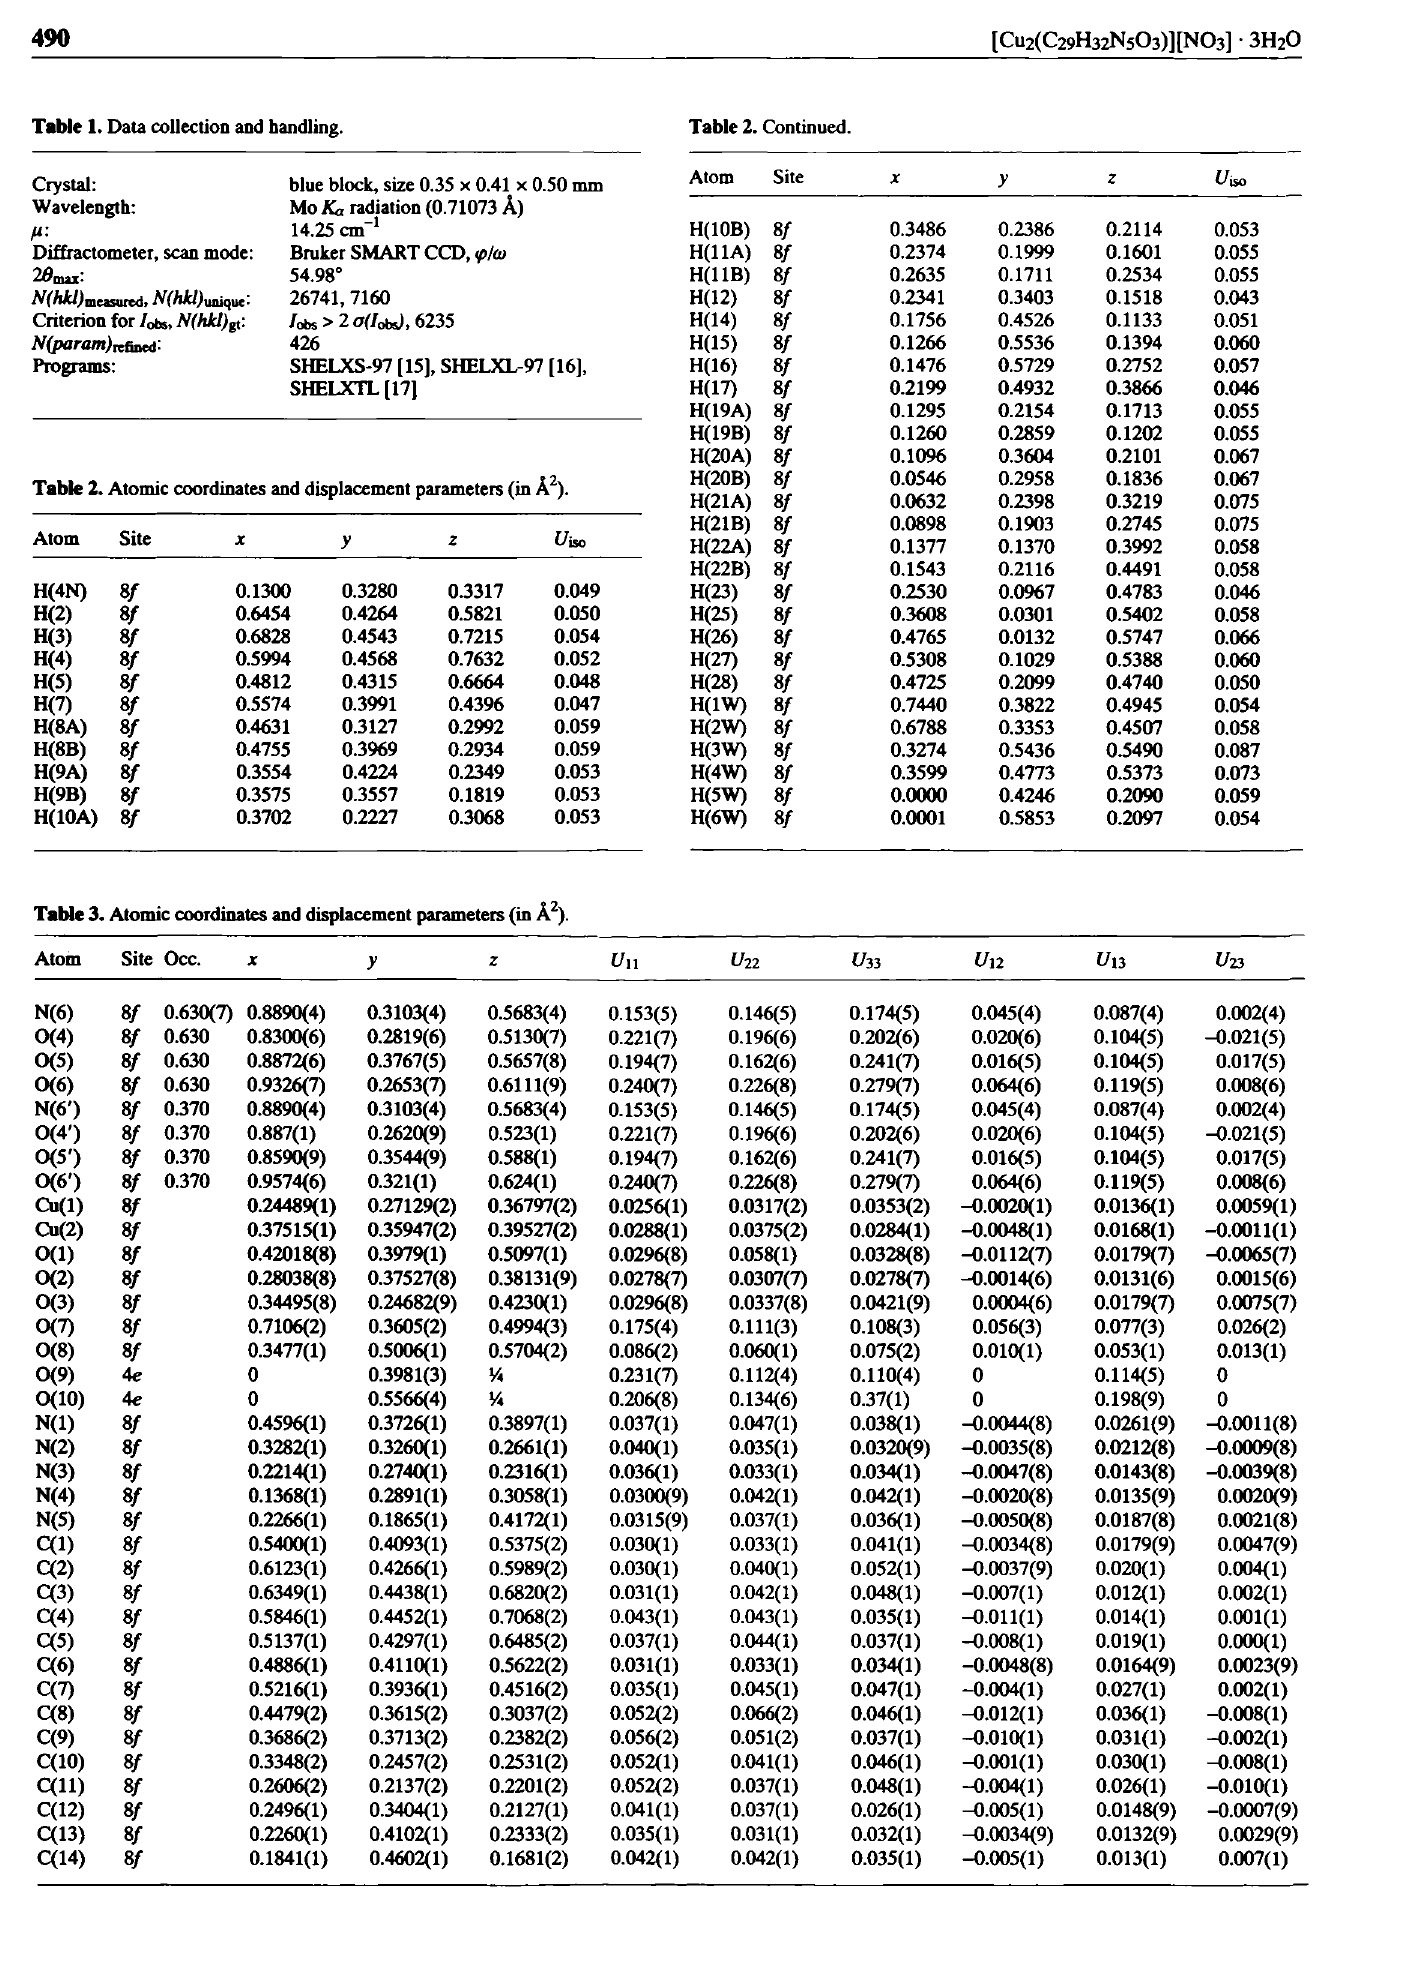
Table 1. Data collection and handling. Table 2. Continued.